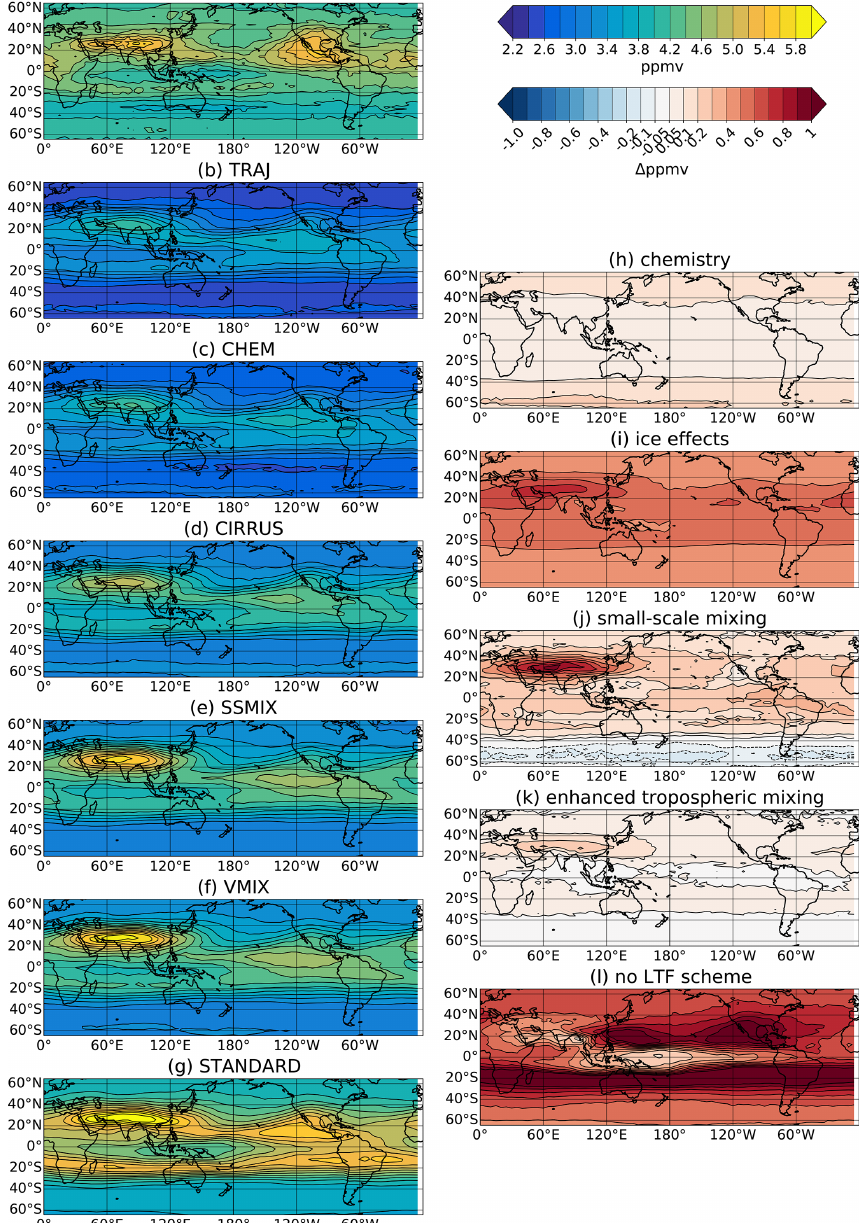
Figure 1. (a–g) Climatology of water vapour distribution at 100hPa during boreal summer (June–July–August) for the period 2007–2016 from (a) Aura MLS v4.2 observations, (b) TRAJ, (c) CHEM, (d) CIRRUS, (e) VMIX, (f) SSMIX and (g) STANDARD simulations. (h–l) Isolated effect of (h) methane oxidation, (i) cirrus, (j) small-scale mixing, (k) enhanced tropospheric mixing and (l) no-LTF scheme. Air parcels have been binned to a 5 ◦ longitude × 2 ◦ latitude